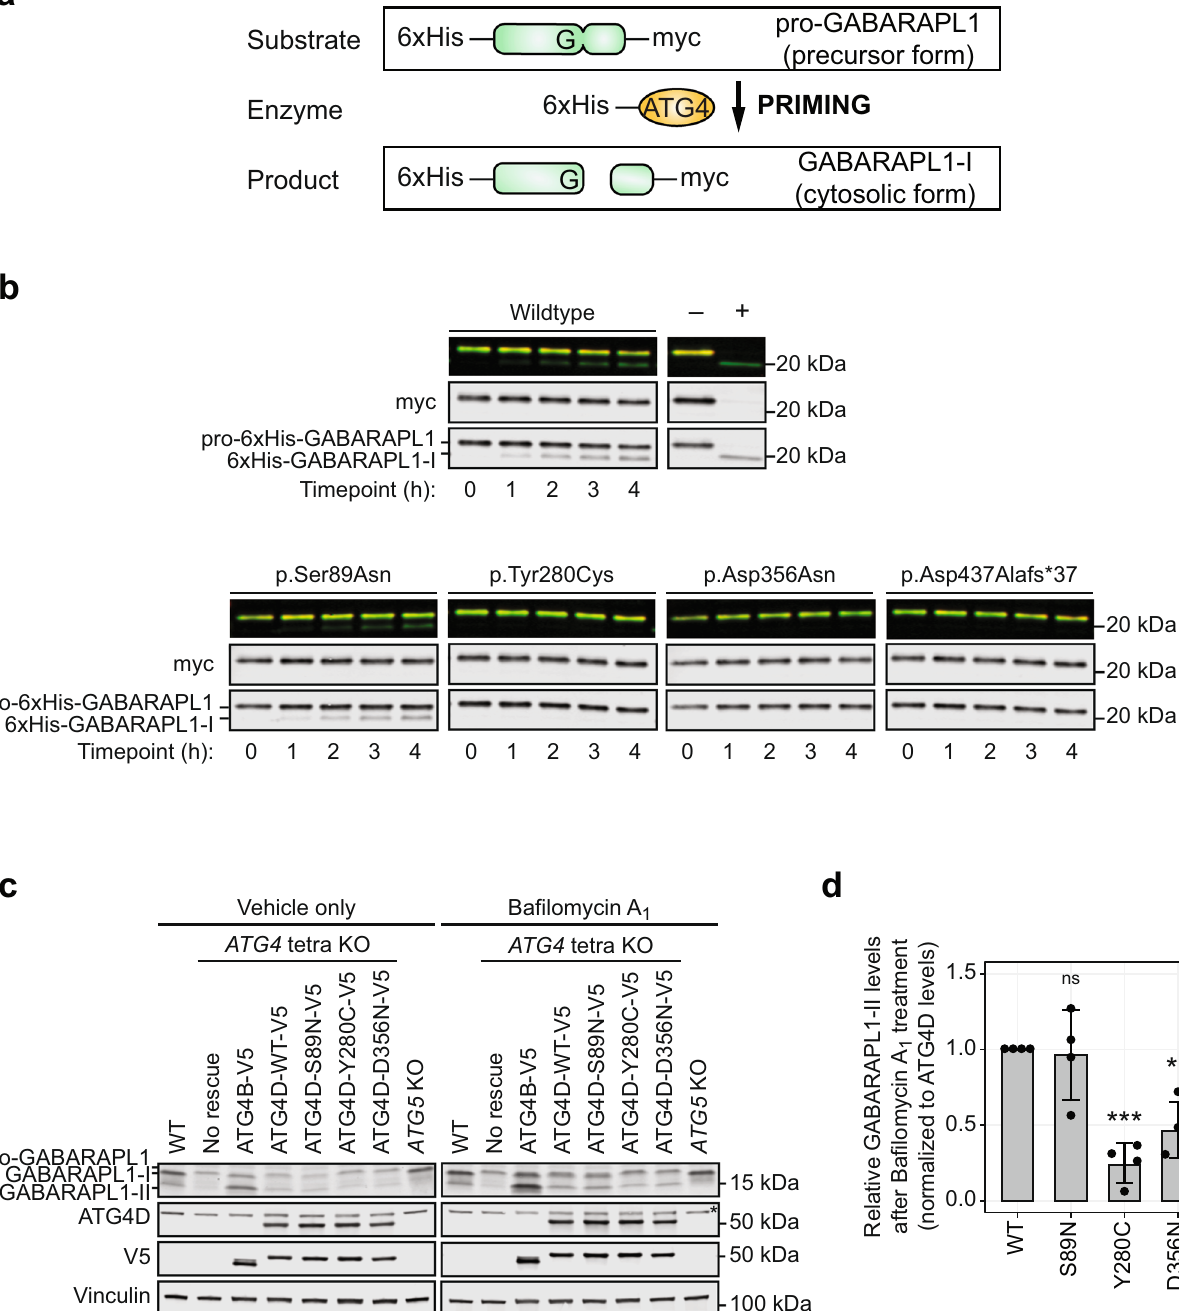
endolysosomal compartments, leading to the conjugation of the LC3/GABARAP subfamily proteins (ATG8s) to phosphatidylserine (PS). Interestingly, ATG4D was the most ef fi cient isoform for delipidating LC3/GABARAP-PS among the ATG4 isoforms and the only isoform to preferentially delipidate LC3/GABARAP-PS over LC3/GABARAP-PE 17 . Further, similar to ATG4A and ATG4B, ATG4D has been found to stabilize GABARAP and GABARAPL1 18,19 . Finally, ATG4D may have an indirect role in GABA receptor traf fi cking in the cerebellum 20,37 , which could contribute to the neuropathol- ogy observed in the Atg4d knockout mouse. These new aspects of ATG4D biology will guide future studies to understand disease